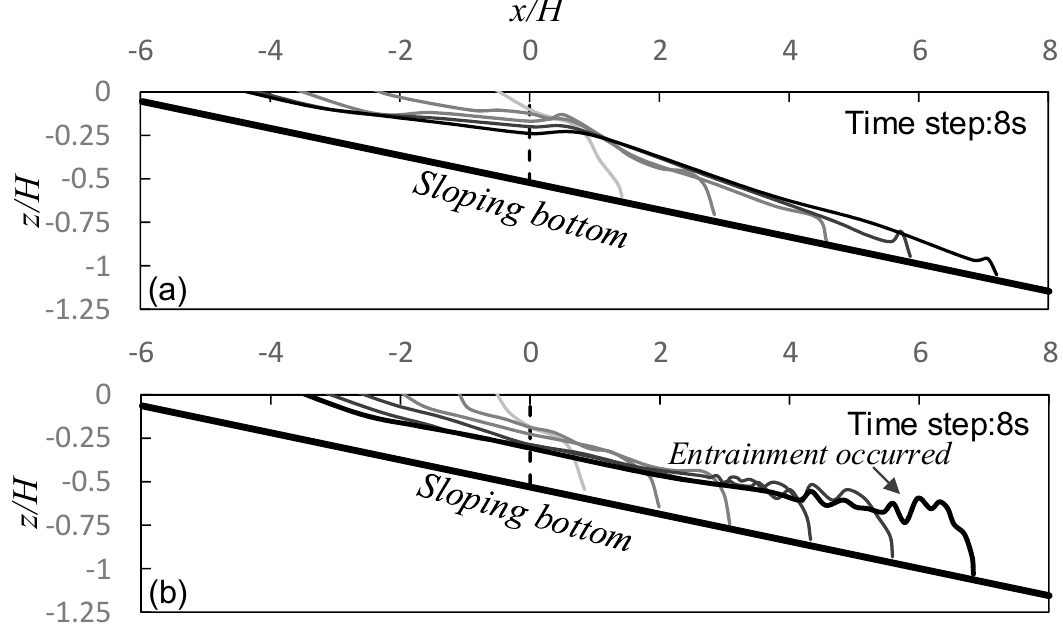
Figure 5. Temporal progression of the interface at a slope of 0.075 (~4.3 ◦ ) and g (cid:48) = 2.1 cm/s 2 : ( a ) Run 8 ( φ = 0% in shallows and φ = 6.9% in deep regions); and ( b ) Run 6 ( φ = 6.9% in shallows and φ = 0% in deep regions). The dashed line is the location of the lock, and the time interval between each profile is provided on the top of each figure.